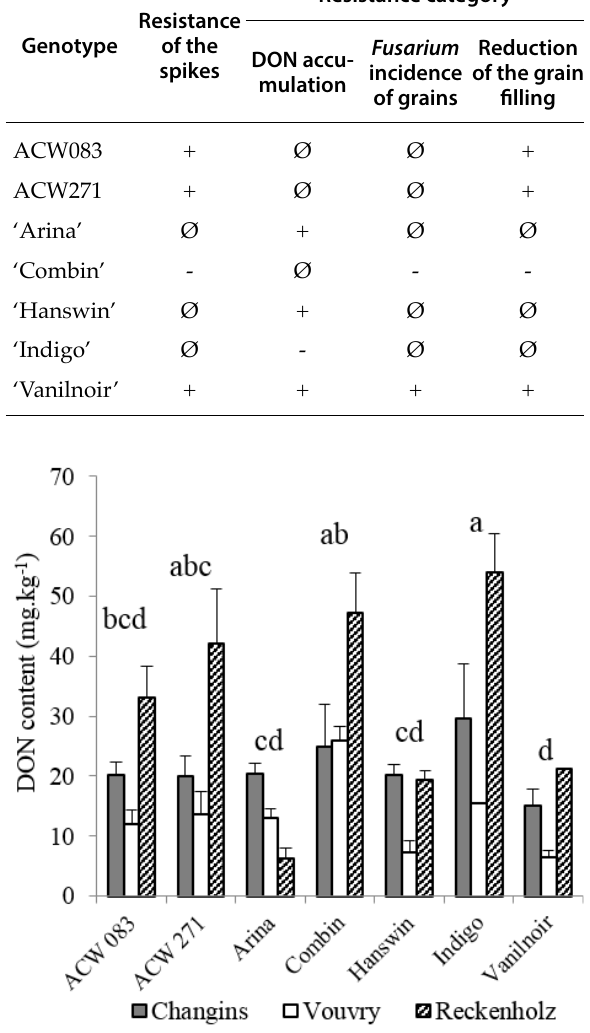
Figure 3. Mean deoxynivalenol (DON) concentrations in grains from seven wheat genotypes grown at three field sites (environments). Bars accompanied by the the same letters are not statistically different ( P